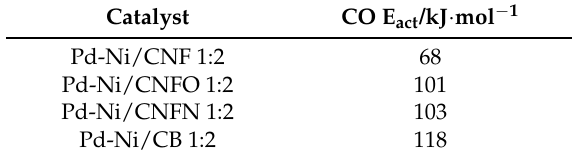
Table 4. CO oxidation activation energies for the synthesized Pd ‐ Ni catalysts.